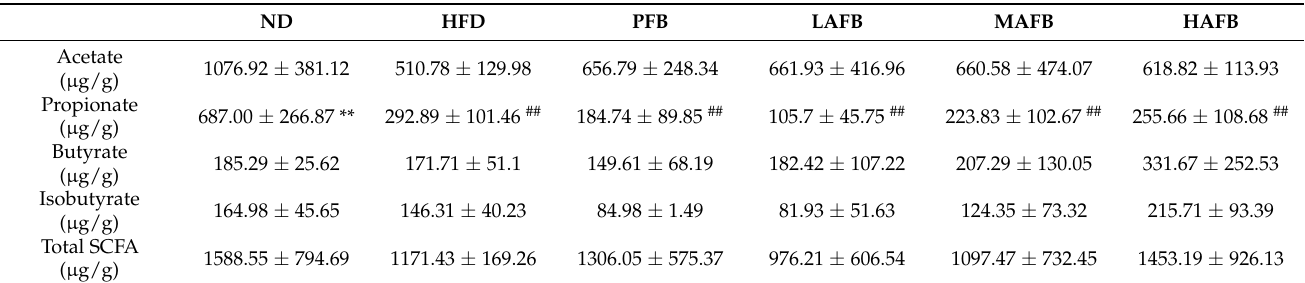
Table 2. Concentration of SCFA in the feces of each group of